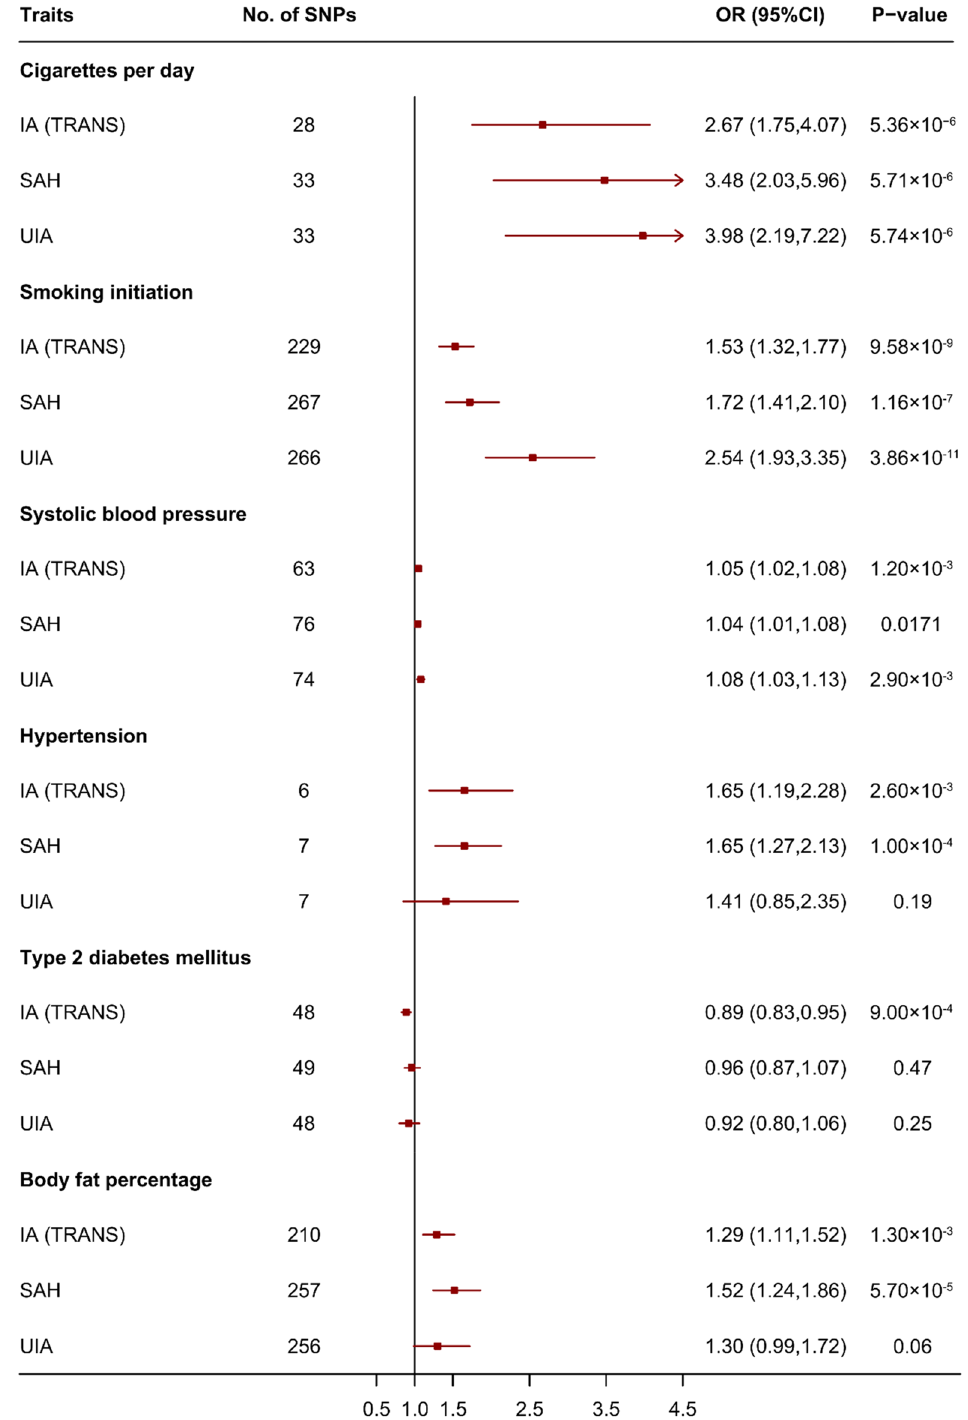
Figure 4. Mendelian randomization for associations between significant risk factors and intracranial aneurysm, subarachnoid haemorrhage and unruptured intracranial aneurysm. SNP: single nucleotide polymorphism; OR: odds ratios; CI: confidence interval; IA: intracranial aneurysm; SAH: subarachnoid haemorrhage; UIA: unruptured intracranial aneurysm; TRANS: